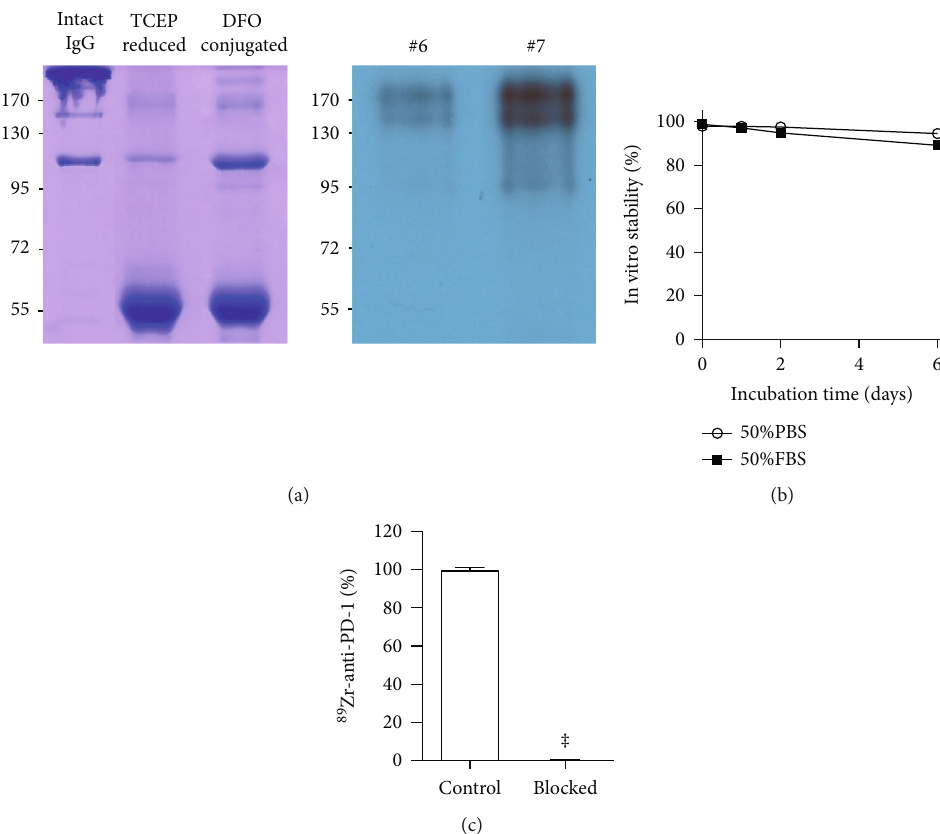
Figure 1: 89 Zr-PD-1 IgG autoradiography, stability, and binding speci fi city. (a) Autoradiography of PD-10 column-eluted fractions of 89 Zr- PD-1 IgG on native PAGE. (b) In vitro radiochemical stability of 89 Zr-PD-1 IgG in PBS and FBS. (c) Complete blocking of 89 Zr-PD-1 IgG binding to EL4 cells by excess cold anti-PD-1 IgG demonstrates excellent target speci fi city. Bars represent the mean ± SD of triplicate samples per group. ‡ P < 0 : 001 .